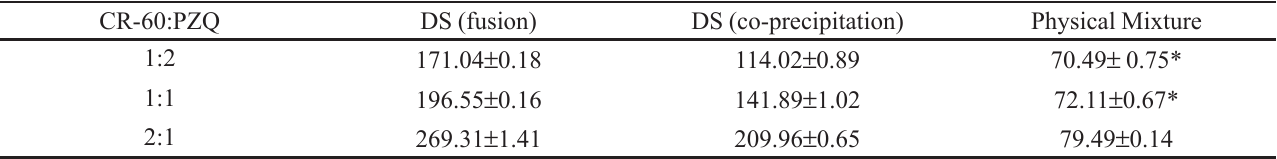
TABLE I - Effect of CR-60 on the solubility of PZQ ( × 10 -1 μg/mL) in water.